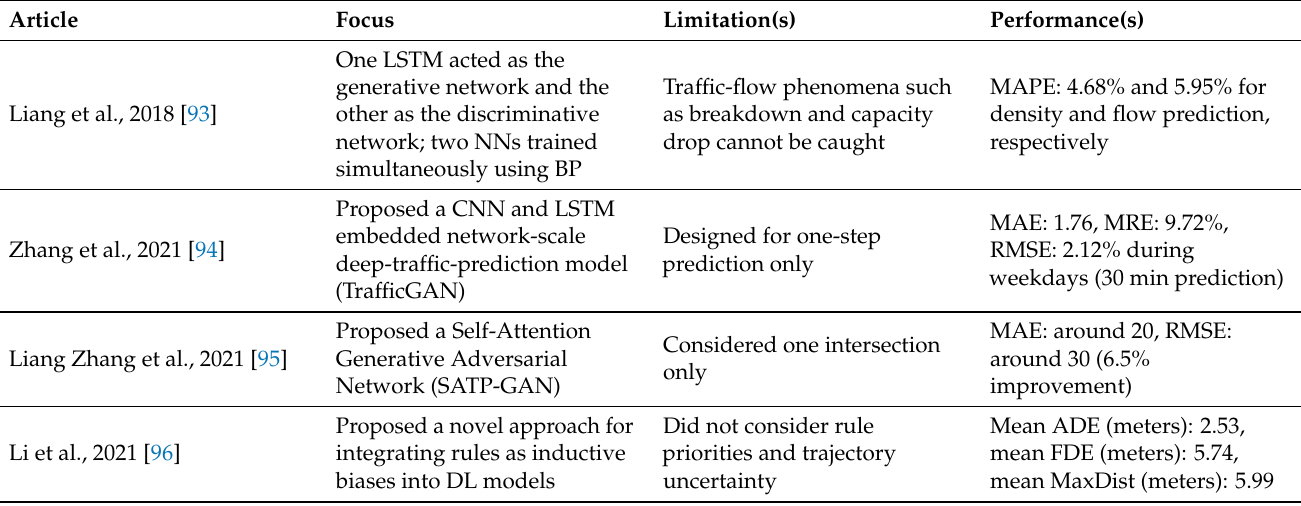
Table 16. Summary of the works found using